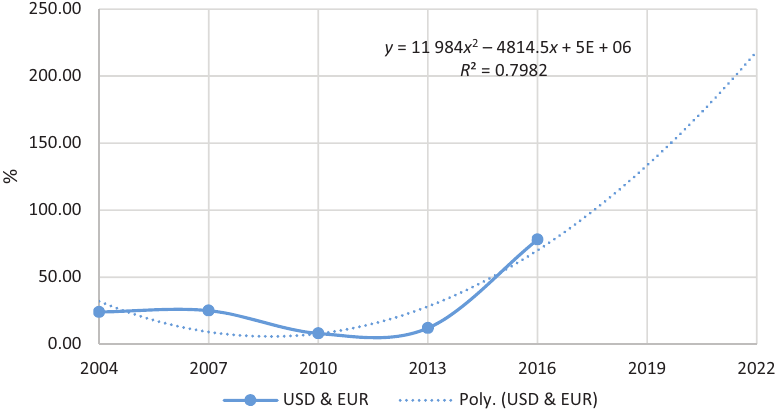
Figure 12. Forecast of the USD/EUR currency pair based on factual data and applying a polynomial function (source: developed by the authors based on LB, 2016, 2018, 2019b; BIS, 2018a, 2018b)